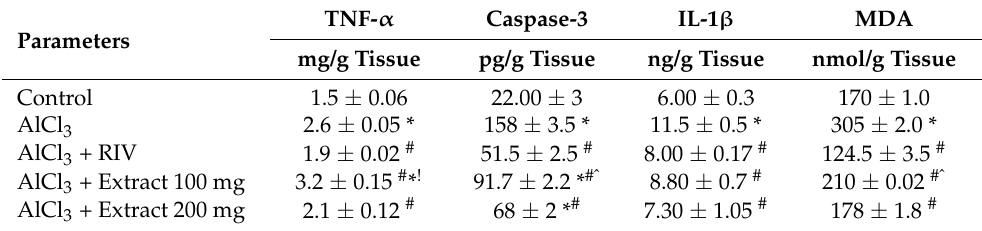
Table 4. Levels of MDA, IL-1 β , caspase-3 and TNF- α in the different treated groups.